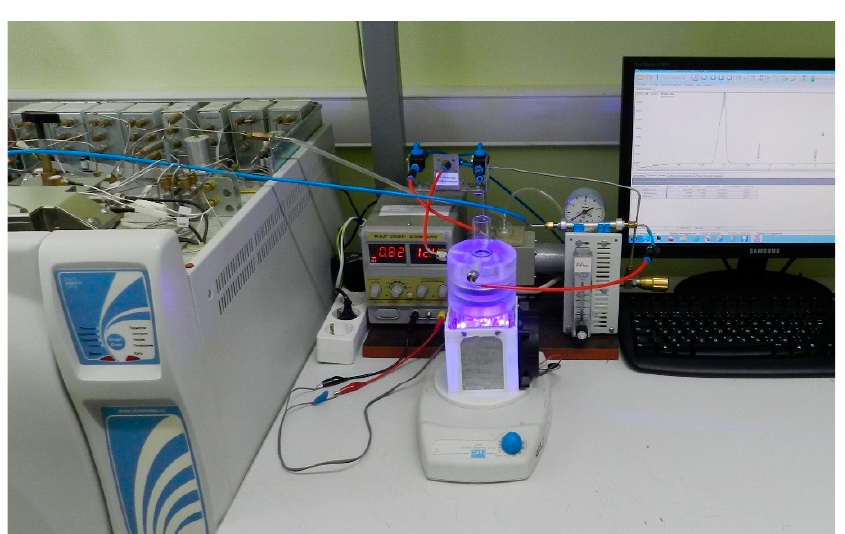
Figure 1. Image of the photocatalytic unit for hydrogen generation with online chromatographic detection.